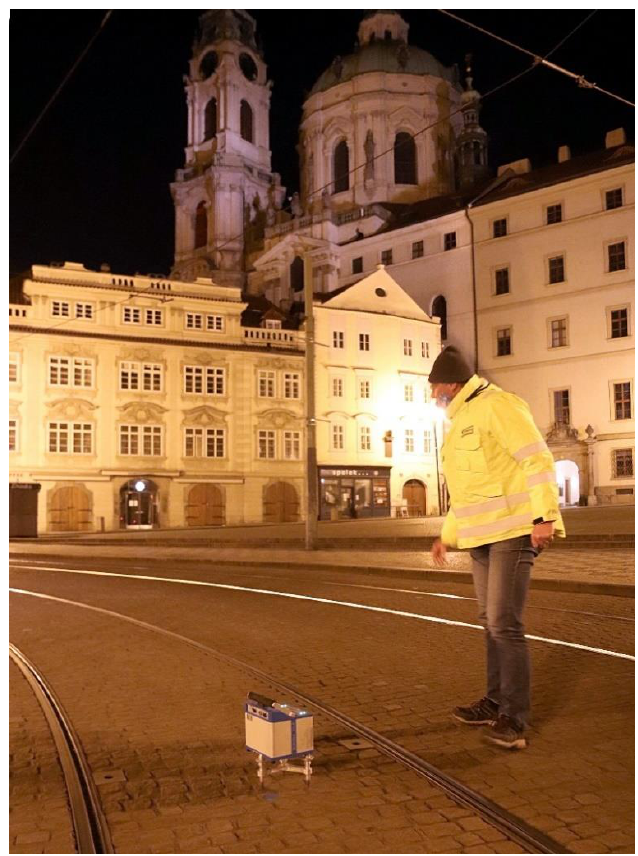
Figure 6. Lesser Town Square with a gravimeter.